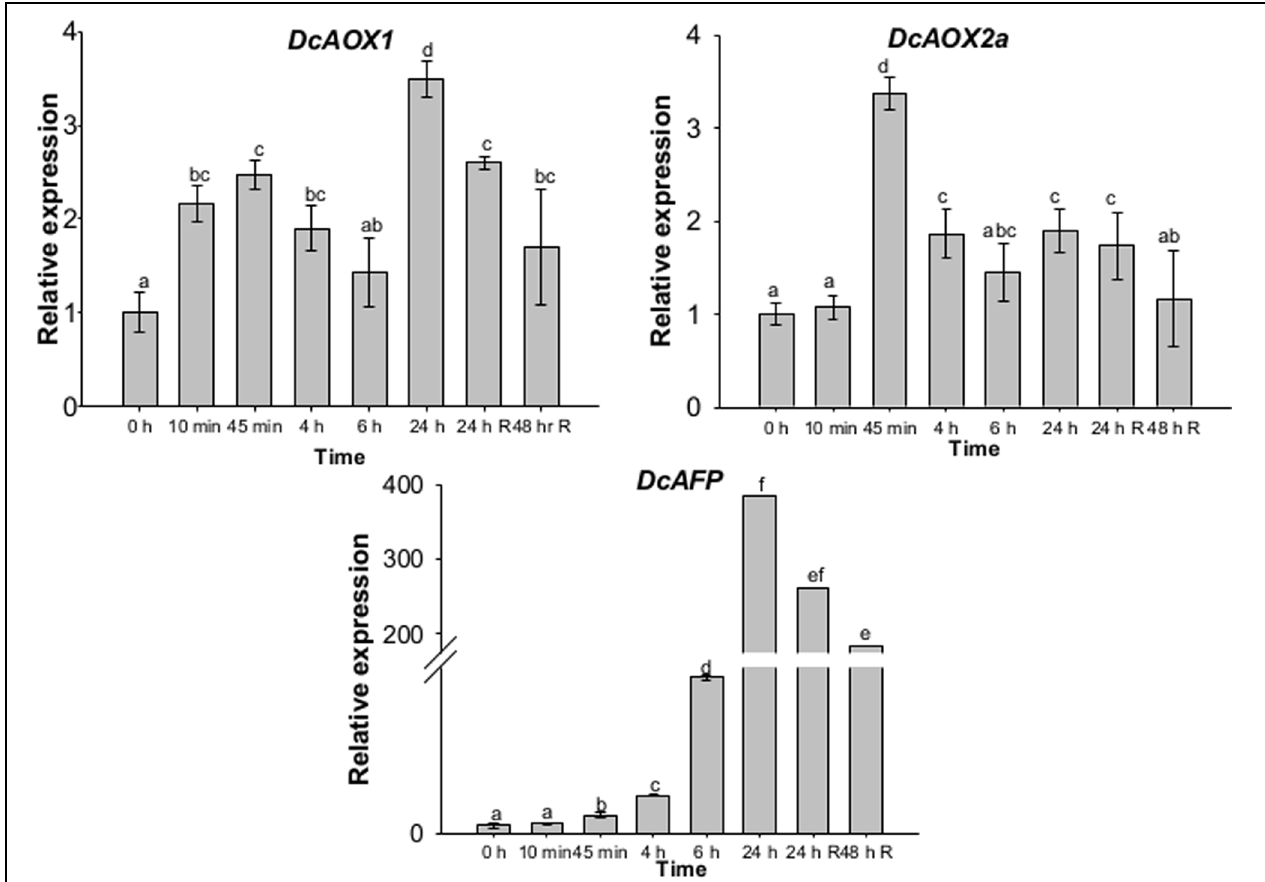
FIGURE 5 | Transcript levels of DcAOX1 , DcAOX2a, and DcAFP during CE in 1-month-old carrot ( Daucus carota L. cv. Rotin) seedlings. Samples were harvested at 0 hpce (immediately before CE) and after 10 min, 45 min, 4, 6, and 24 h of exposure at 4 ◦ C and after 24 and 48 h after transferring plants back to the initial growth conditions (recovery period). Expression data was analyzed by RT-qPCR using DcEF1 α as reference gene. Data are the mean values ± SE of four plants considered per time point. Statistical analysis (one-way ANOVA with Tukey’s post hoc test) was applied to each gene separately. Different superscript